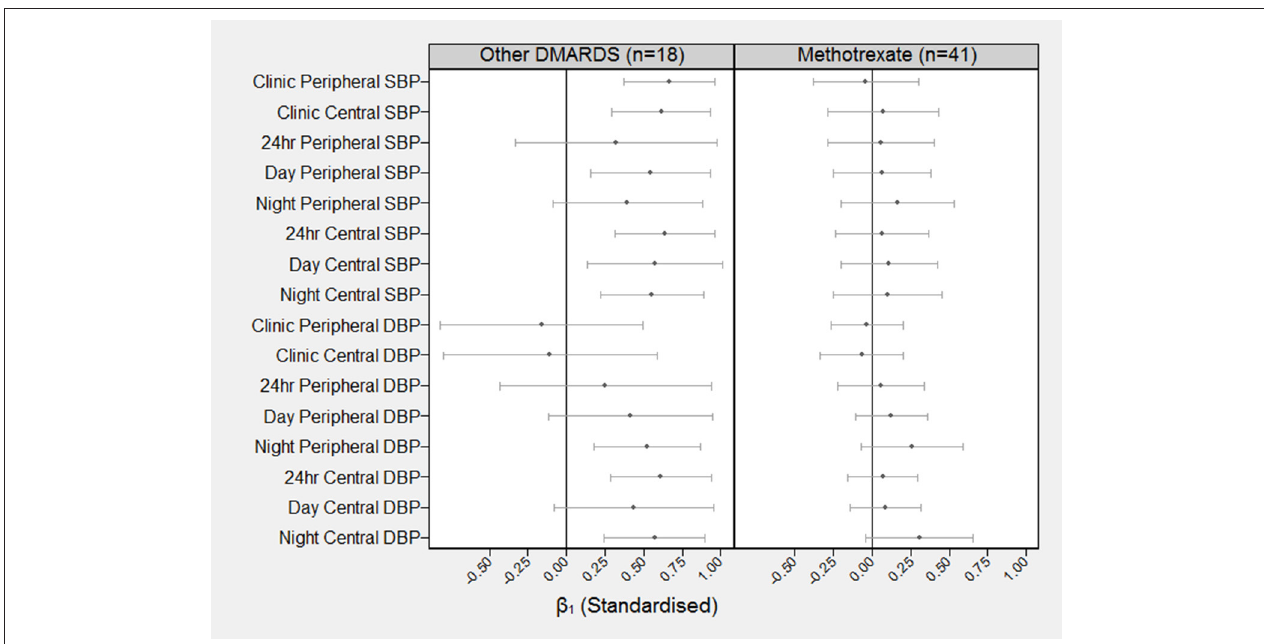
FIGURE 2 | Standardized coefficients (and 99.7% confidence intervals) describing the correlation between baseline PWV and BP at follow-up BP ( β 1 ). The standardized β 1 can be interpreted as the number of SD increases in BP at 8 months for each one SD increase in PWV at baseline. For example, the standardized β 1 coefficient for baseline PWV on clinic peripheral SBP for the other DMARDS group is β 1 = 0.66 (99.7% CI = 0.37–0.96).